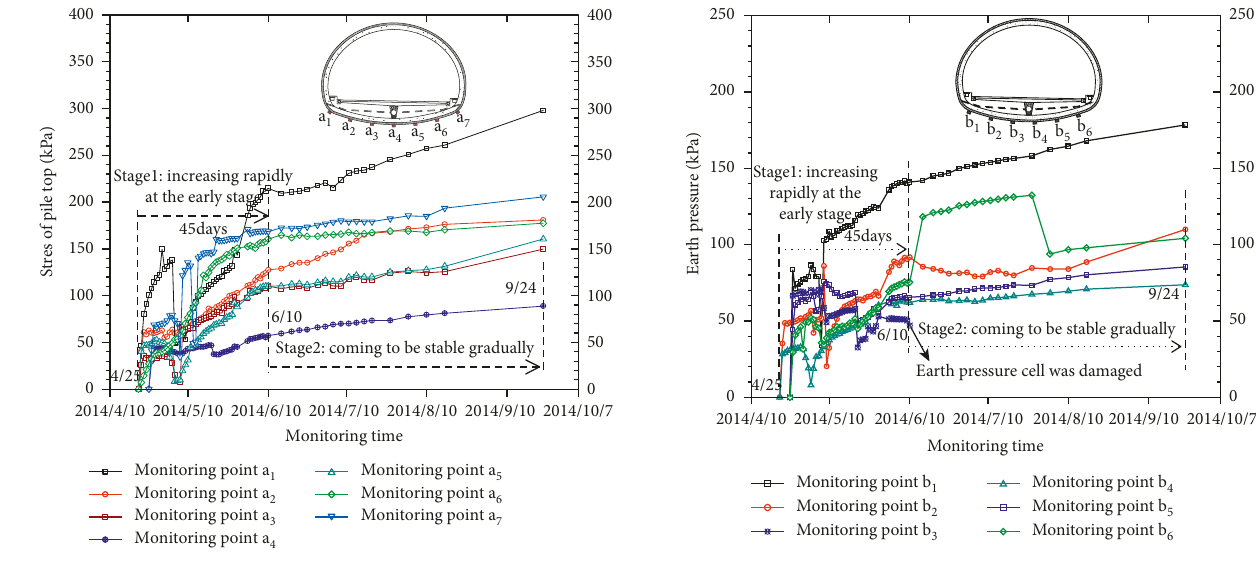
Figure 8: Variation of the stress on pile tops with time. Figure 10: Variation of the earth pressure with time.